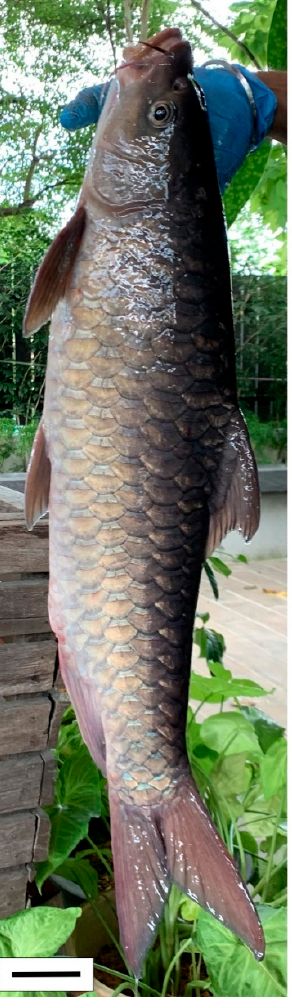
Figure 1. T. tambroides from an aquaculture farm in the state of Negeri Sembilan, Malaysia. Note: Scale bar = 5 cm. Table 2. List of reported Tor species in Southeast (SE) Asian